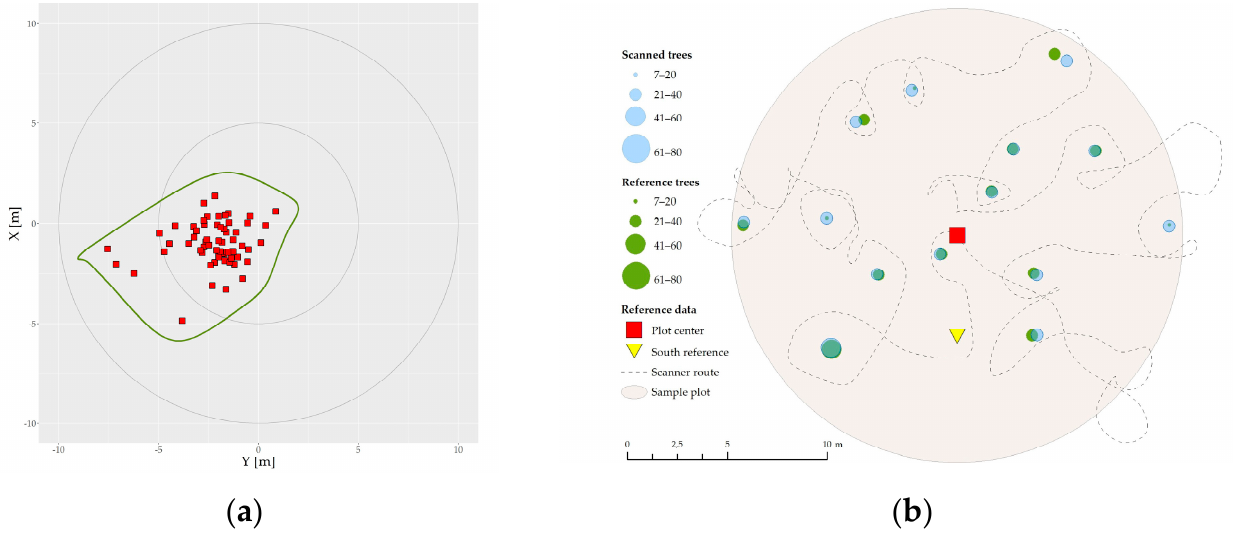
Figure 3. Sample plot schemas: ( a ) diagram of the sample plots center extracted from the scans (red square) according to the real sample plot location; ( b ) the vector visualization of one of the sample plot data sets with scanned and referenced trees represented by the circle with diameter breast height expressed in centimeters.